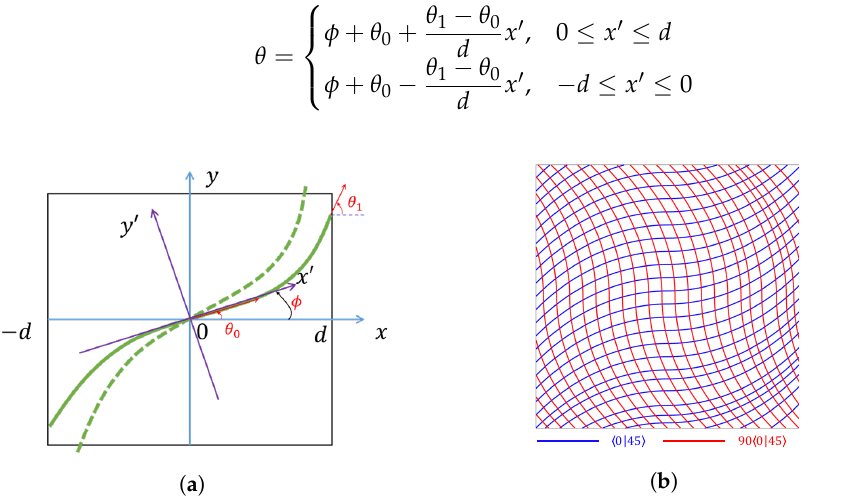
Figure 1. Linearly varying fiber path angle with a rigid rotation for a VAT lamina [20]. ( a ) Linearly varying fiber path angle; ( b ) two representative linearly varying VAT